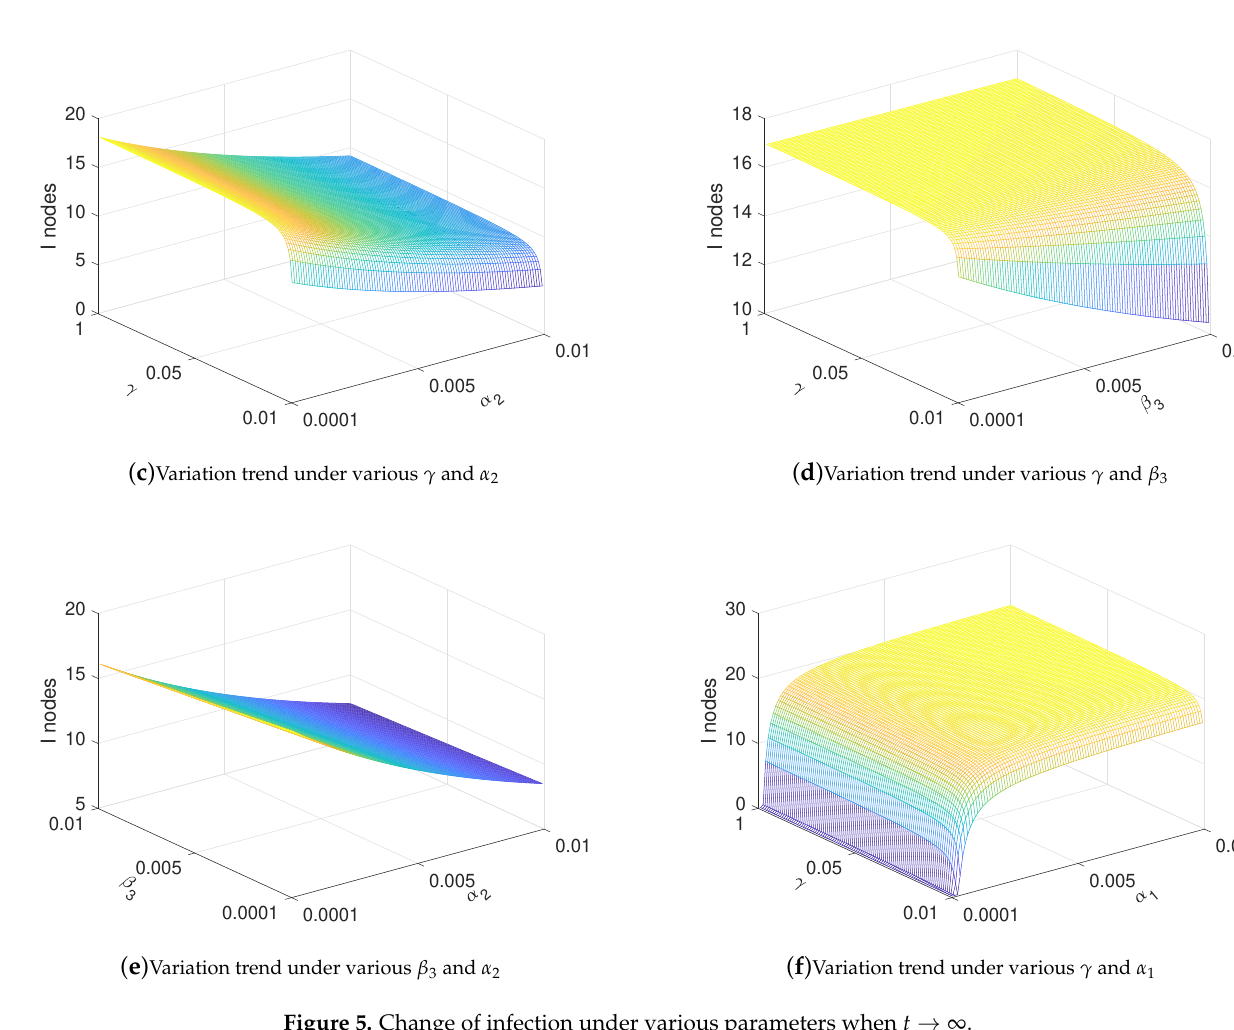
Figure 5. Change of infection under various parameters when t → ∞